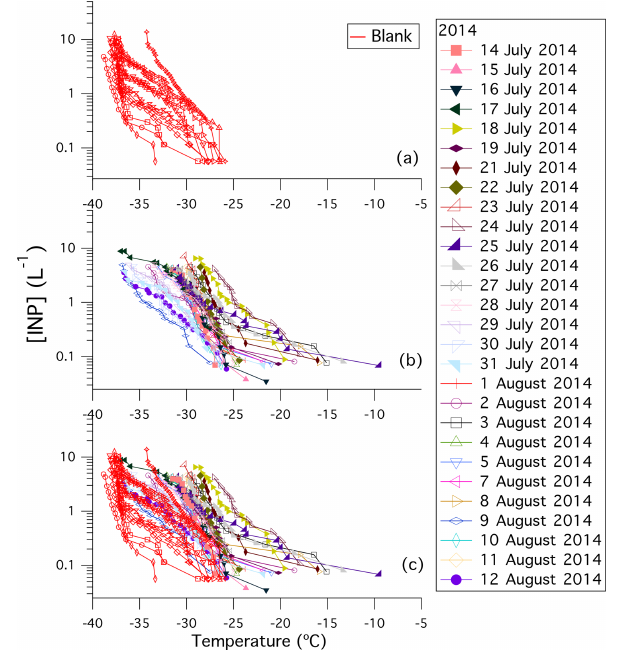
Figure 2. Plot of [INP] (L − 1 ) as a function of temperature ( ◦ C) for (a) the blanks, (b) the samples, and (c) the blanks and samples. The [INP] (L − 1 ) of 11 blanks are shown in (a) and (c) . Each blank was performed on a separate hydrophobic glass substrate. Error bars are not shown to improve the visibility of the data in the graph. Error bars in the x direction are ± 0 . 3 ◦ C for each datapoint. Error bars in the y direction were calculated using nucleation statistics following Koop et al. (1997); the errors for our measured [INP] (L − 1 ) can be seen in Fig. S5.